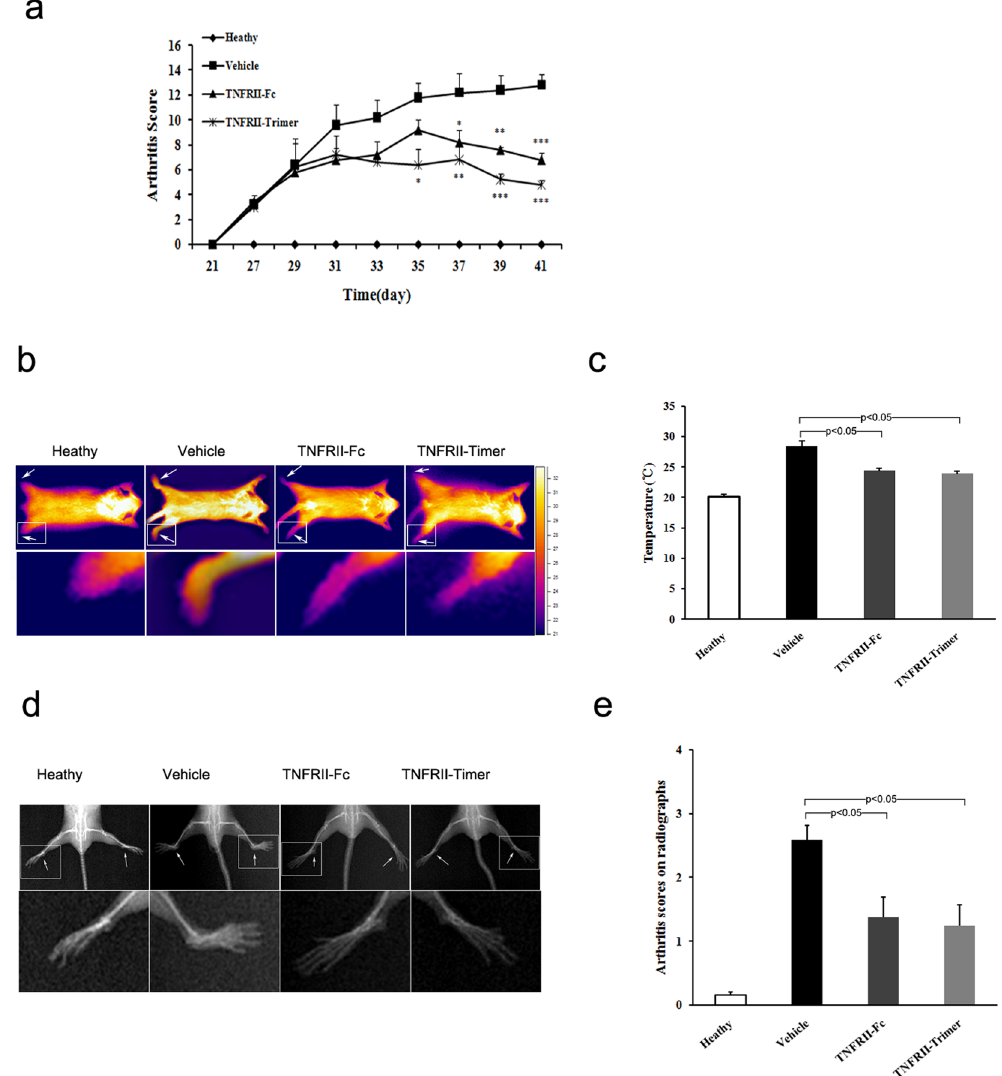
Figure 6. Inhibition of established CIA by TNFRII-Trimer. ( a ) Comparison of arthritis scores from DBA/1 mice treated with either TNFRII-Trimer or TNFRII-Fc. The results were representative of four independent observers. * p < 0.05, ** p < 0.01, *** p < 0.001 ( b ) Representative images of infrared thermography (IRT) of the hind paws of the CIA mice on day 41. In comparison with healthy control and treatment groups, hind paws from vehicle group of mice showed significantly higher temperature and severe swelling (indicated by arrows). ( c ) Comparison of hindpaws’ temperature from DBA/1 mice treated with either TNFRII-Trimer or TNFRII-Fc. Regional temperature was analyzed by XJ-Infrared report analysis software. Values were mean ± SD (n = 5). ( d ) Representative images of radiograph of the hind paws of CIA mice on day 41. As compared with healthy control and treatment groups, hind paws from vehicle group of mice were significantly deformed, swollen, and with joint space narrowing (indicated by arrows). ( e ) Comparison of the degree of joint swelling and bone erosion from DBA/1 mice treated with either TNFRII-Trimer or TNFRII-Fc. Values were mean ± SD (n = 5). The results were from a representative